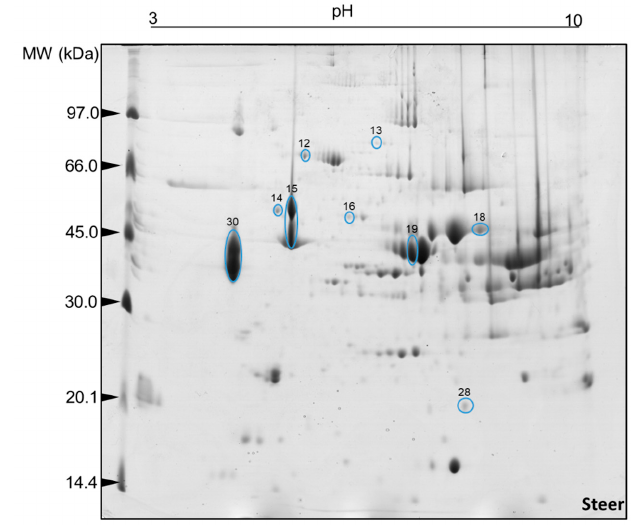
Figure 2. Protein spots selected for characterization by mass spectrometry (ESI-MS) after image analysis. Two-dimensional polyacrylamide gel electrophoresis (2D-PAGE): 12.5% ( w/v ) and pH gradient 3–10. Muscle tissue samples ( Longissimus thoracis ) from immunocastrated F1 Montana- Nellore young steers feedlot finished. The information on the number IDs of differentially abundant spot proteins are given in Table 3.